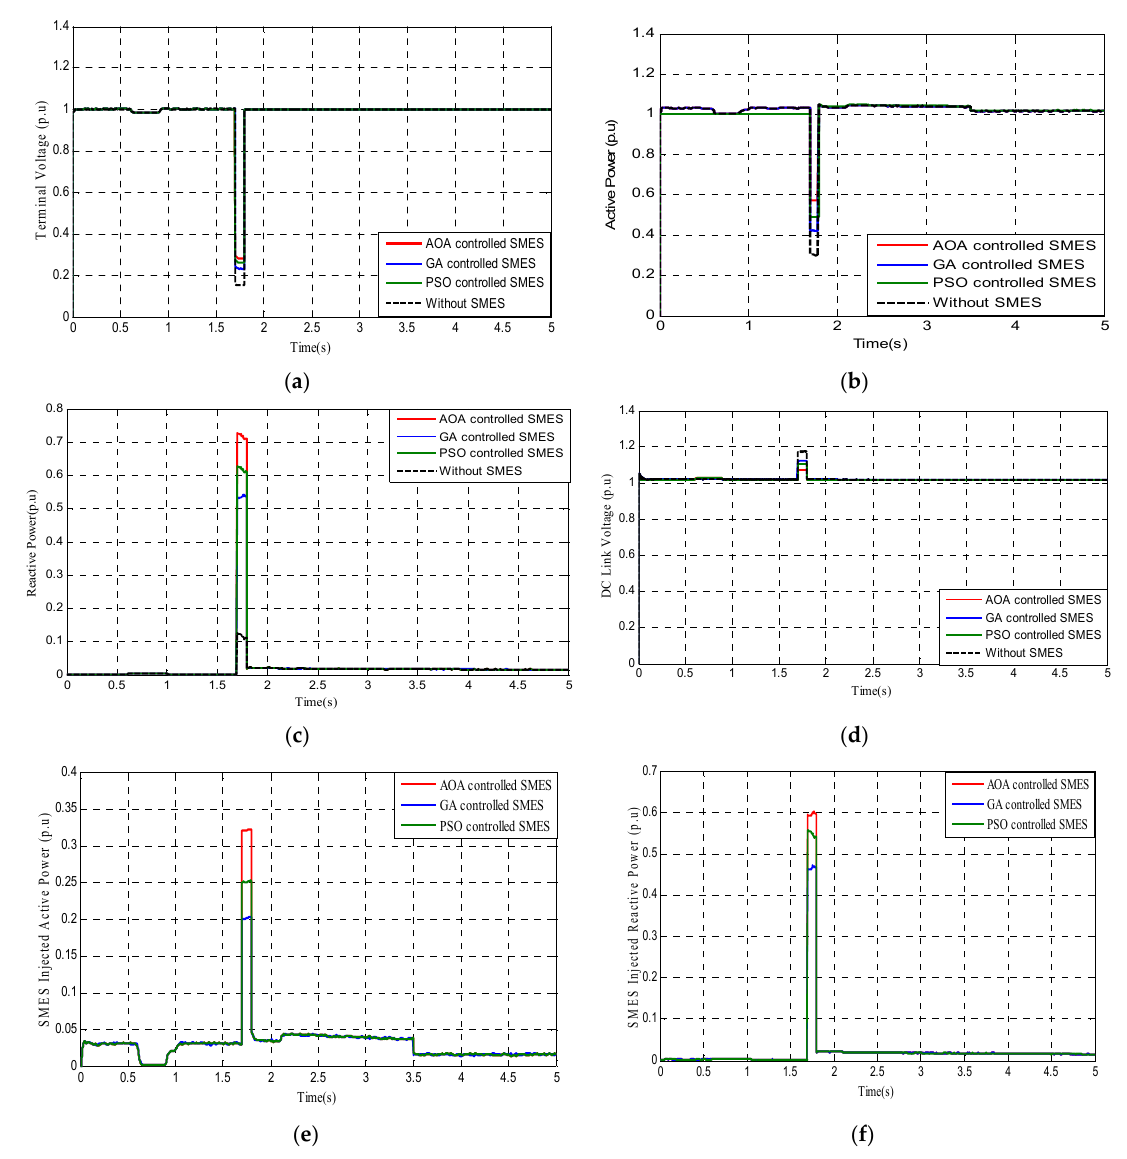
Table 7. SMES-injected active and reactive power for L-L-G scenario.